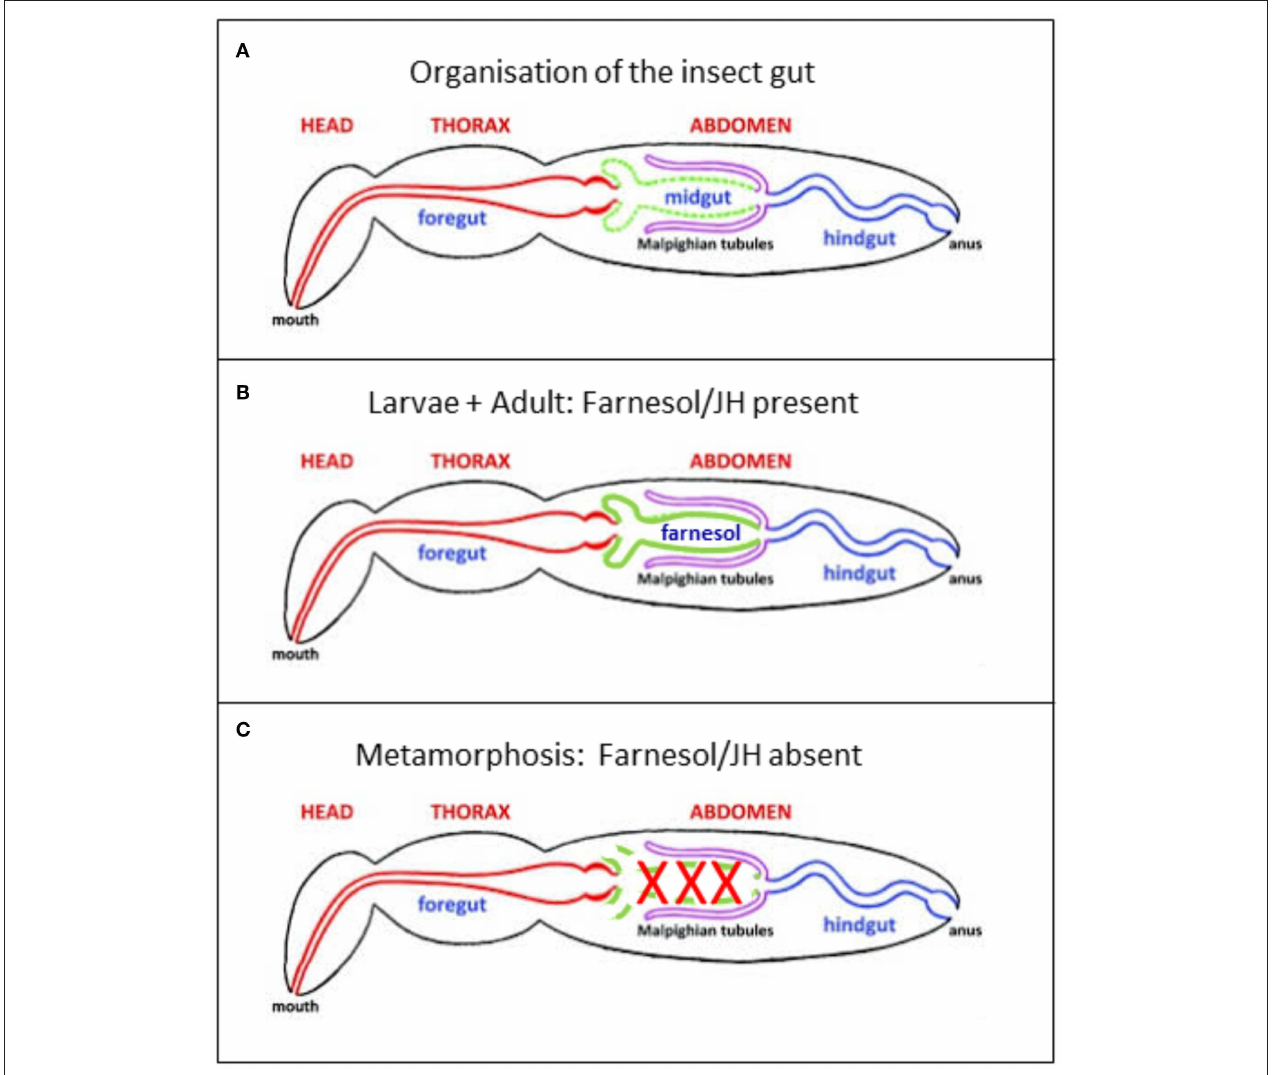
FIGURE 4 | (A) Generalized insect digestive system illustrating the three main regions. Repeatedly modified from Imms (37). This version was modified by Michael L. Ferro. Posted on bugwood Wikimedia in 2011. (B,C) Further modifications. (B) In the presence of a high titer of endogenous farnesol-like sesquiterpenoids, in particular of JH, during young larval stages and during adult life, all parts of the alimentary canal remain intact. It has been shown by Schmialek (7) that farnesol and farnesal are present in the lumen of the gut of mealworm larvae. (C) When at the onset of the last larval instar the titer of endogenous farnesol-like sesquiterpenoids in the hemolymph drops to zero, the midgut starts undergoing programmed cell death/apoptosis. Next, it is remodeled into the adult gut, starting from stem